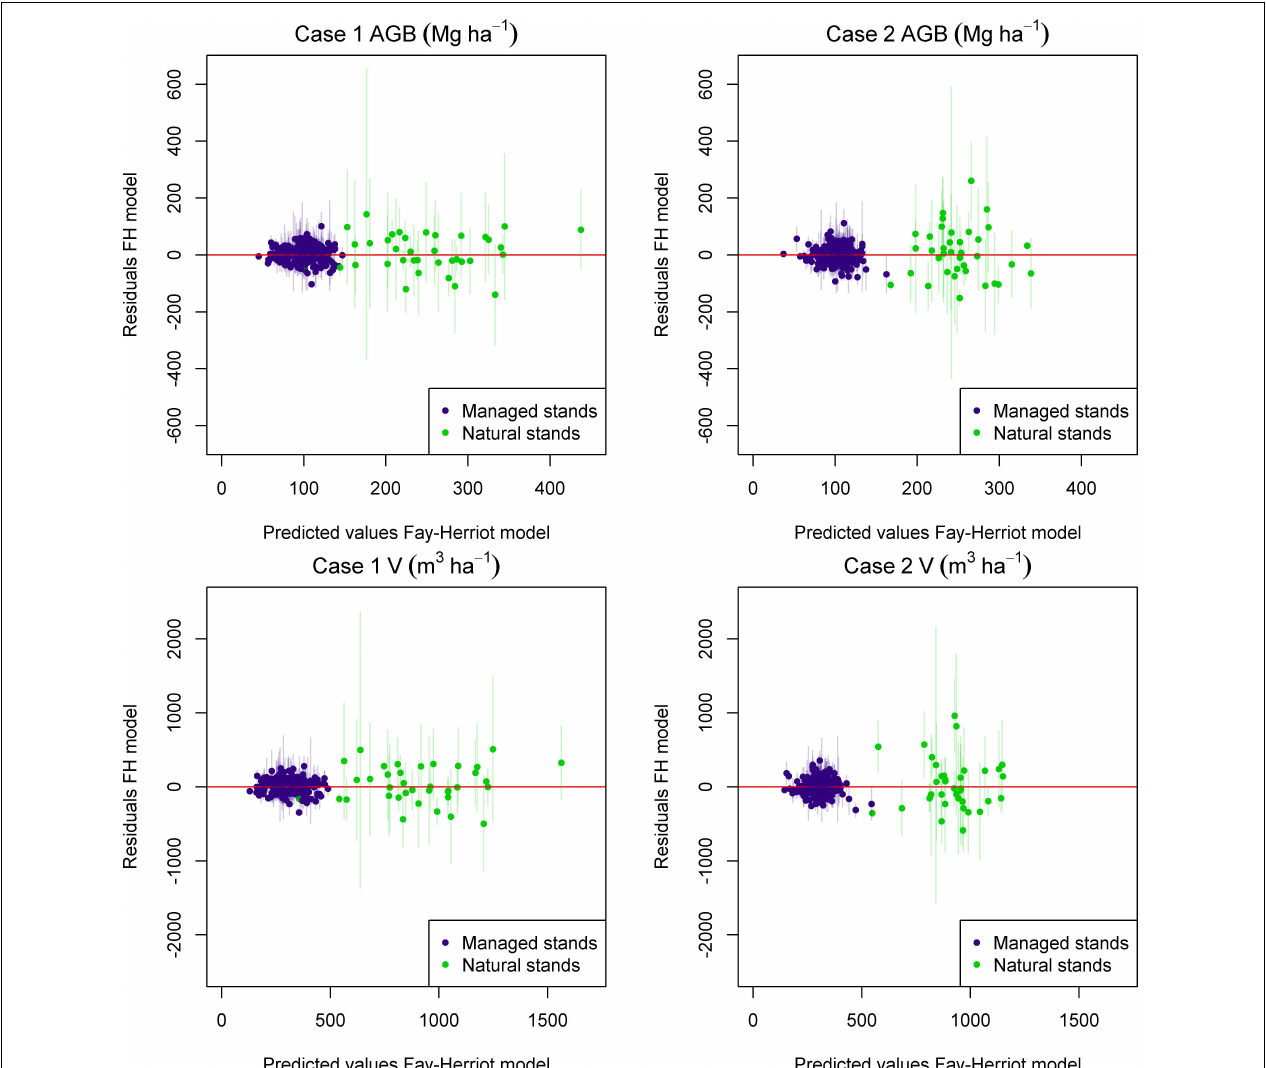
FIGURE 4 | Predicted vs. residuals plots for FH models for above-ground biomass (AGB) and volume (V) for Case 1 and Case 2. Whiskers around each point with a width of 1.96 times the standard deviation of the direct ground estimate are included to reference the uncertainty of the field estimates associated with each data point. Residuals were computed as b µ gi ∗ − x t i b β , with b µ gi ∗ the direct ground estimate for the stand and x t computing the EBLUP).